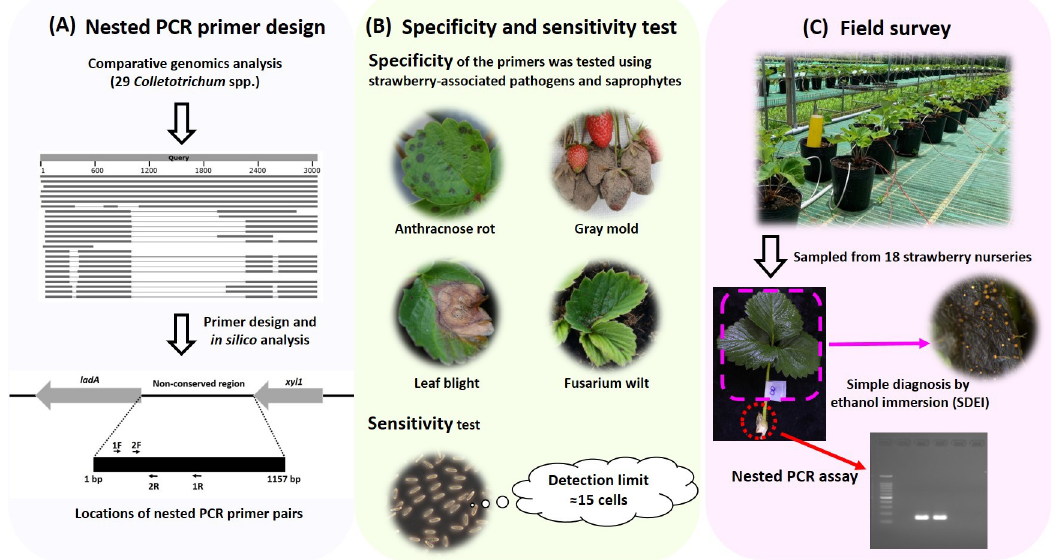
Fig 1. Workflow diagram for the nested PCR primer design, specificity and sensitivity tests, and field survey in this study. (A) Comparative genomics analysis and in silico analysis were conducted to identify non-conserved regions suitable for designing nested PCR primers. (B) Specificity and sensitivity tests of nested primers. Specificity was determined by testing the ability of primers to amplify strawberry-associated pathogens and saprophytes. The detection limit was ~15 cells of C . siamense . (C) Samples collected from 747 mother plants in 18 strawberry nurseries were assayed by the nested PCR and simple diagnosis by ethanol immersion (SDEI) methods.